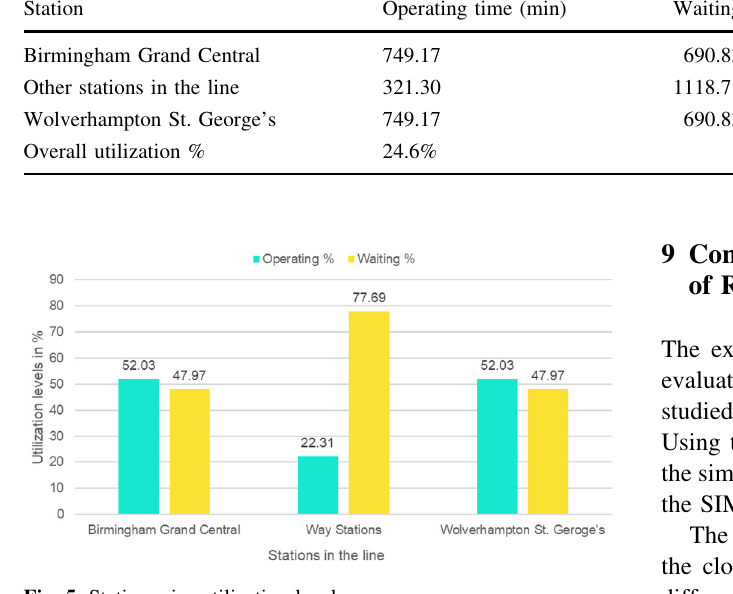
Fig. 5 Station wise utilization levels